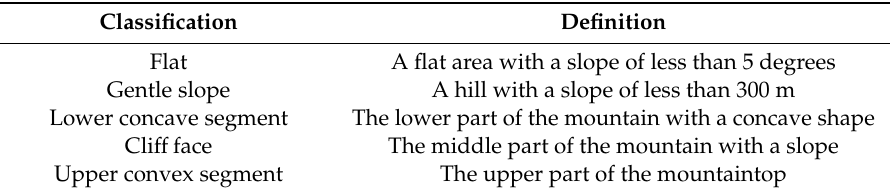
Table 2. Landform classification.